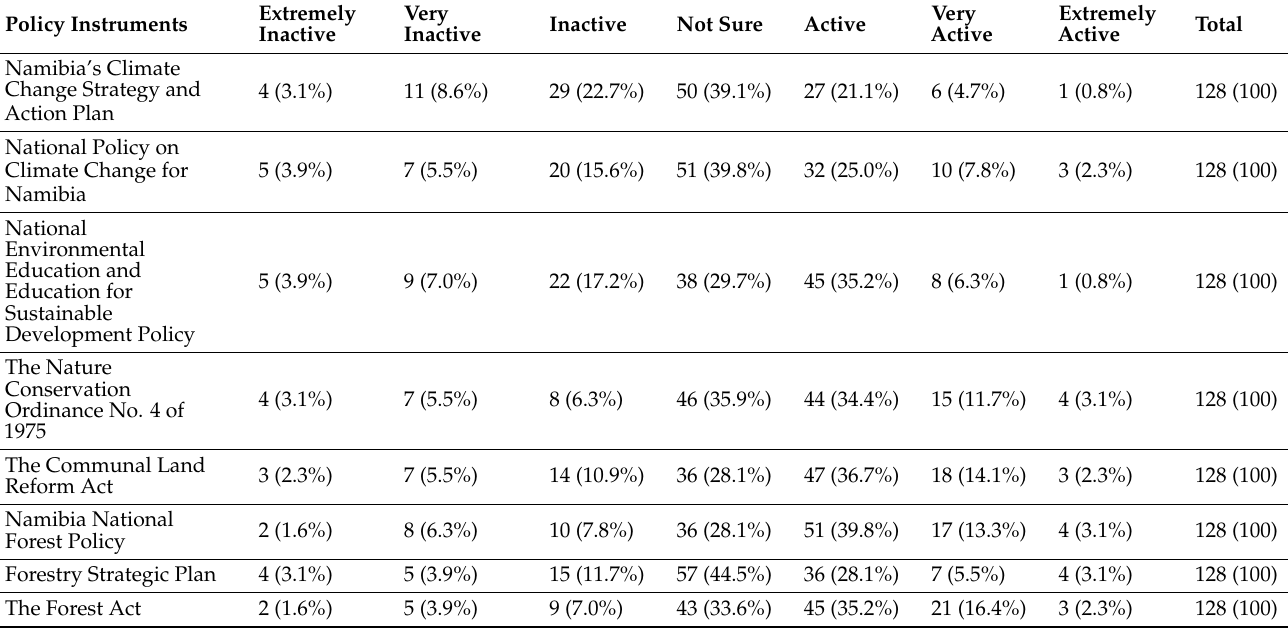
Table A3. The implementation of policy